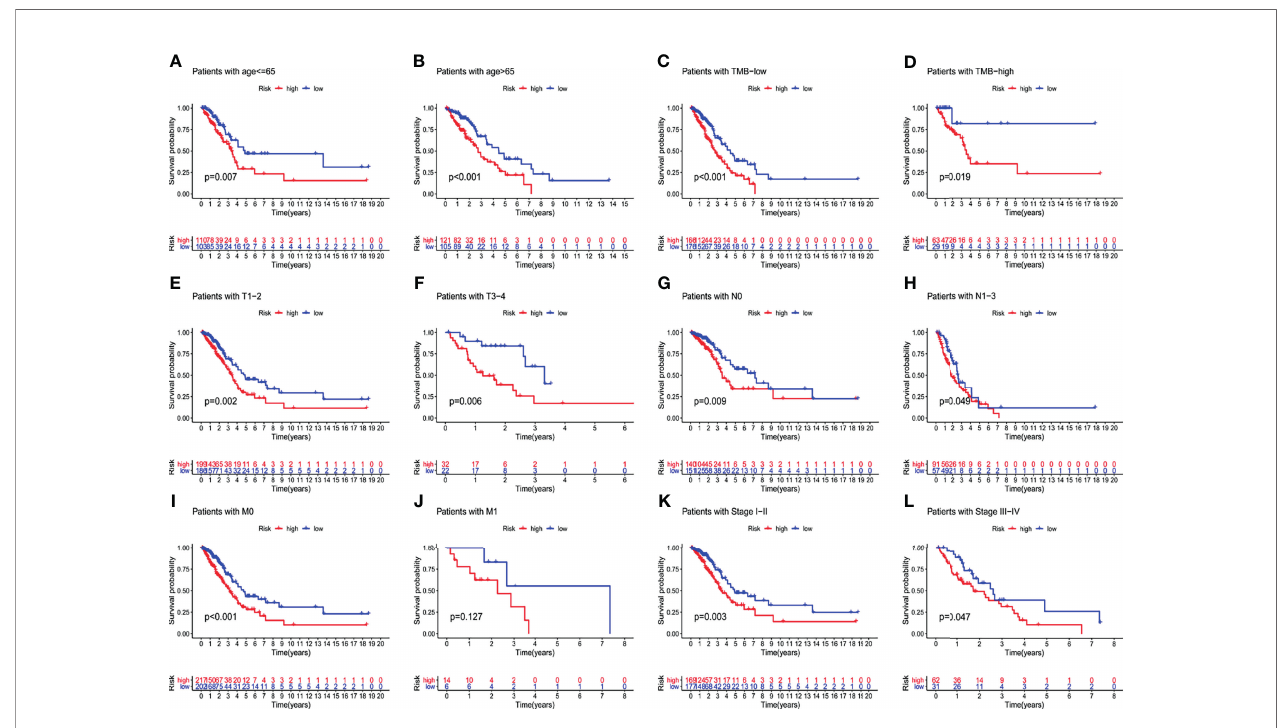
FIGURE 6 | Explore the performance of GILncSig in the overall survival of various clinical factors in LUAD patients by using the Kaplan-Meier survival curve. Groups classi fi ed by age (A, B) ; TMB (C, D) ; tissue involvement (E, F) ; lymphatic involvement (G, H) ; metastasis (I, J) and stages (K, L)